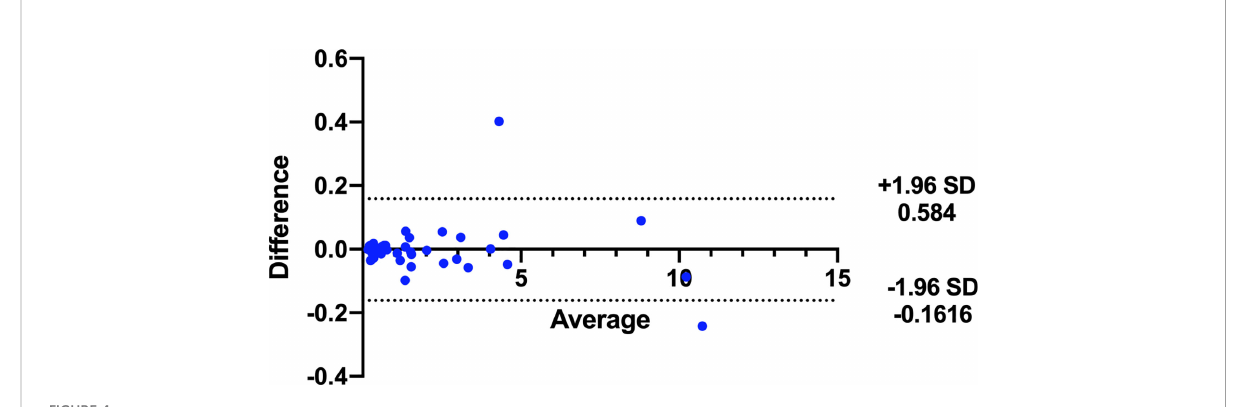
FIGURE 4 Bland-Altman analysis of tumor volumes measured by two doctors using the pixel method.